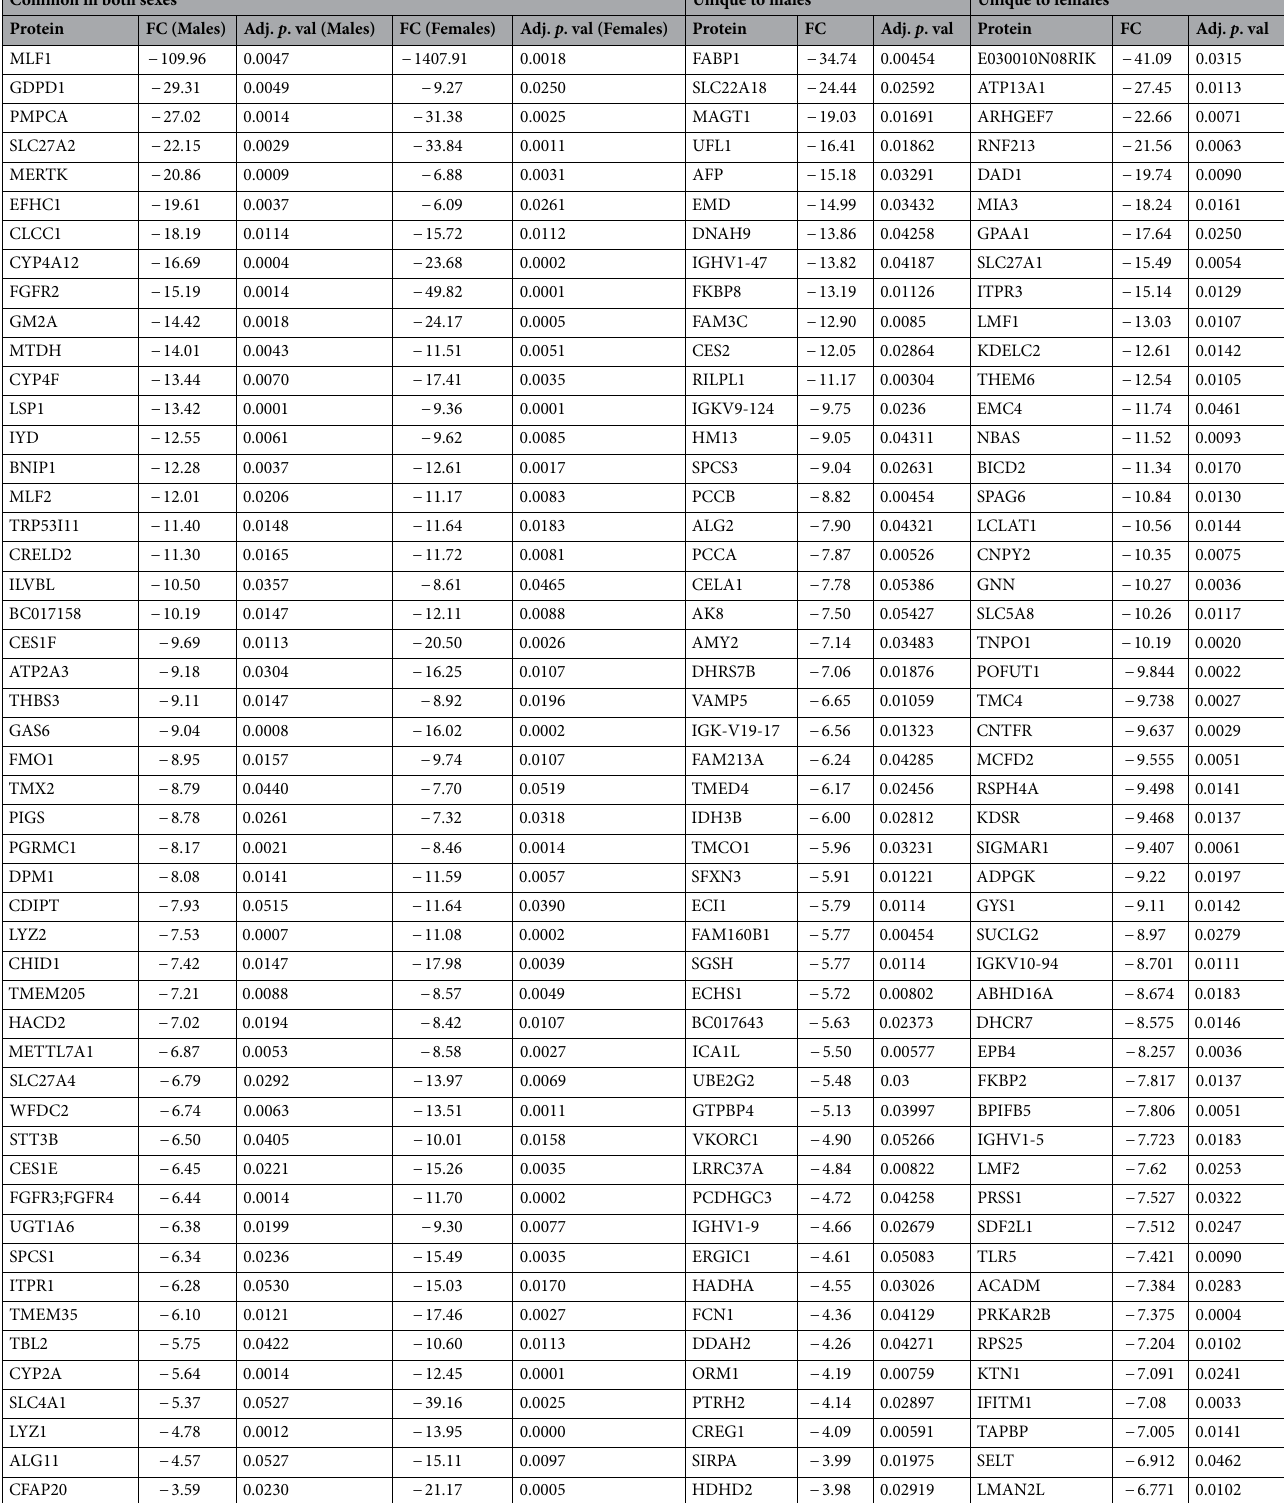
Table 4. Top 50 protein signatures that had significantly reduced abundance in ozone-exposed mice versus air-exposed